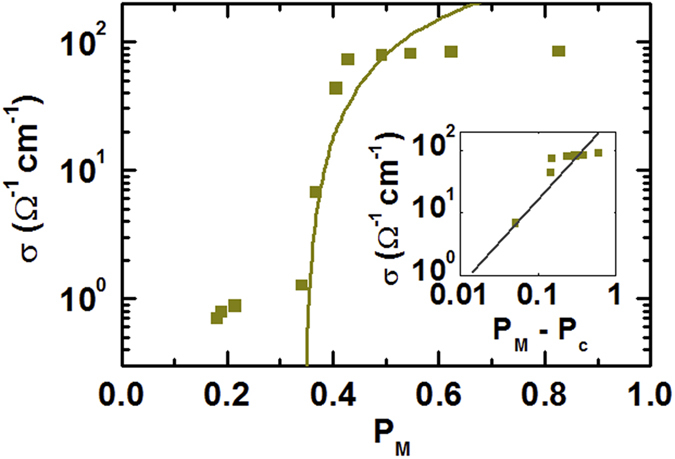
The conductivity, σ, as a function of PM during heating. The solid line fits the data correspond to the two-dimensional (2D) percolation model, σ, ∝ (PM – PC)t; the inset shows a log-log plot of σ, versus (PM – PC), where PC is the percolation threshold.